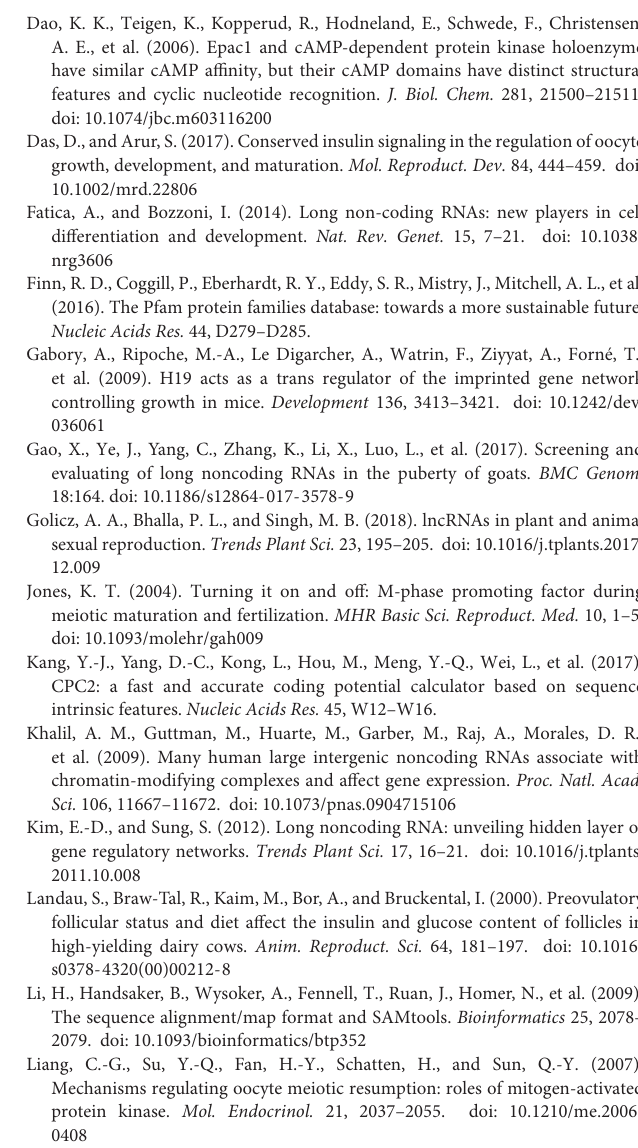
TABLE S1 | Results of differential expression analysis of lncRNAs. TABLE S2 | Results of differential expression analysis of mRNAs. TABLE S3 | Results of co-expression analysis. TABLE S4 | Co-expressed gene pairs of reproduction related GO terms. TABLE S5 | Classes of lncRNAs for co-location. TABLE S6 | Estrogen cis- gene pathway. TABLE S7 | cAMP cis- gene pathway. TABLE S8 | Candidate core lncRNA-mRNA networks. TABLE S9 | Target genes of